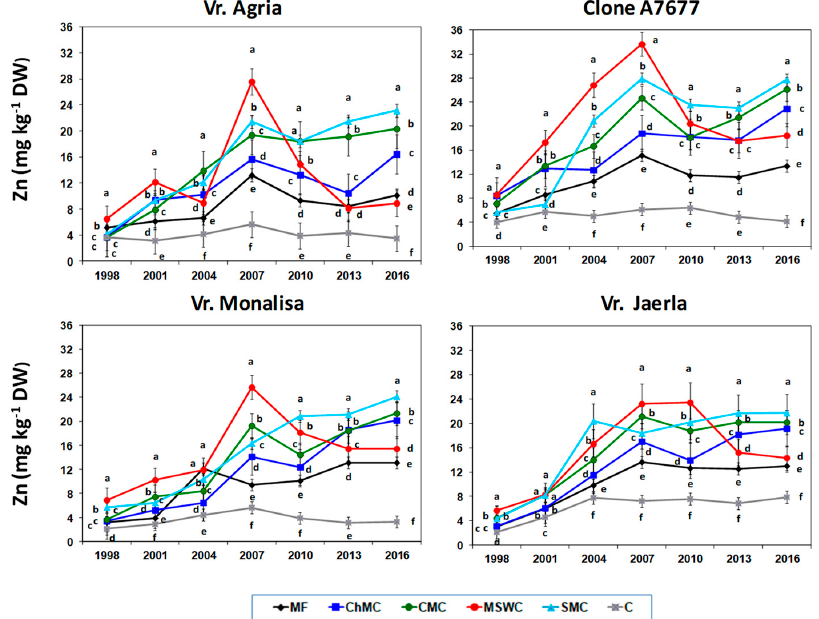
Figure 8. Evolution of manganese content (mg kg − 1 DW) in potato tubers of the Agria, Monalisa, Jaerla and clone A7677 varieties (1998–2016) versus the application of compost from different organic amendments. The means with different lowercase letters within each season indicate significant differences between the treatments ( p < 0.001). Bars stands for standard deviations. MF: mineral fertilizer; ChMC: chicken manure compost; CMC: cow manure compost; MSWC: municipal solid waste compost; SMC: sheep manure compost; C: control.